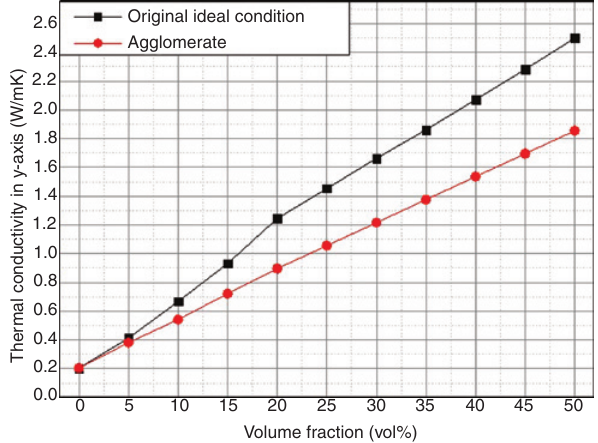
Figure 8: Investigation of influence from the dependence on particle